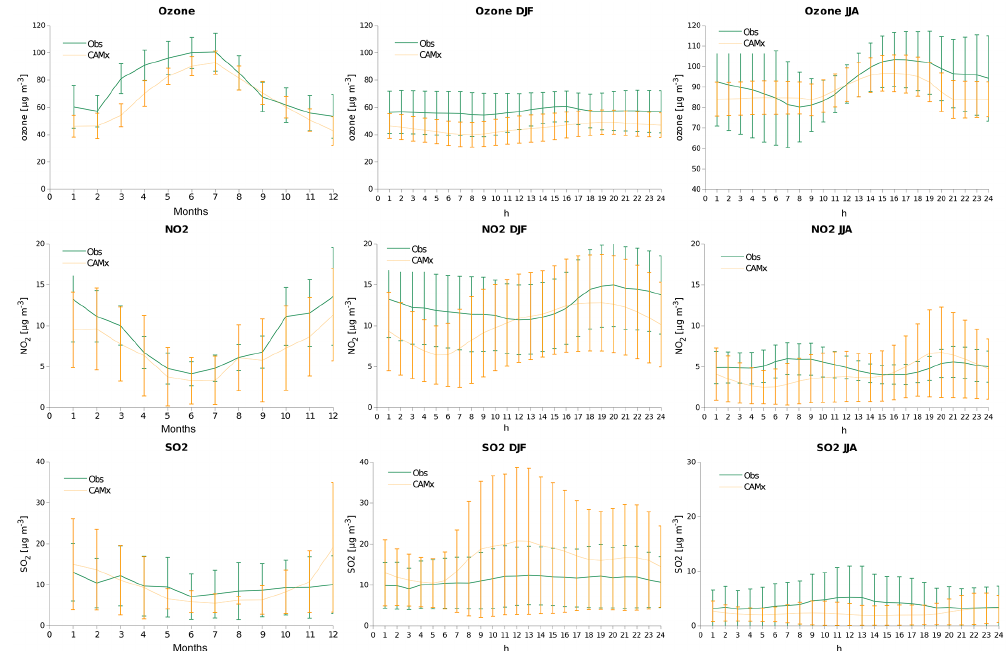
Figure 4. Left column: comparison of the 2001–2010 mean monthly variation of O 3 , NO 2 and SO 2 averaged over all stations with vertical error bars indicating the standard deviation of the average. Middle column: comparison of the 2001–2010 DJF mean diurnal variation for the same species with error bars indicating the standard deviation of the average. Right column: same as middle column but for summer months